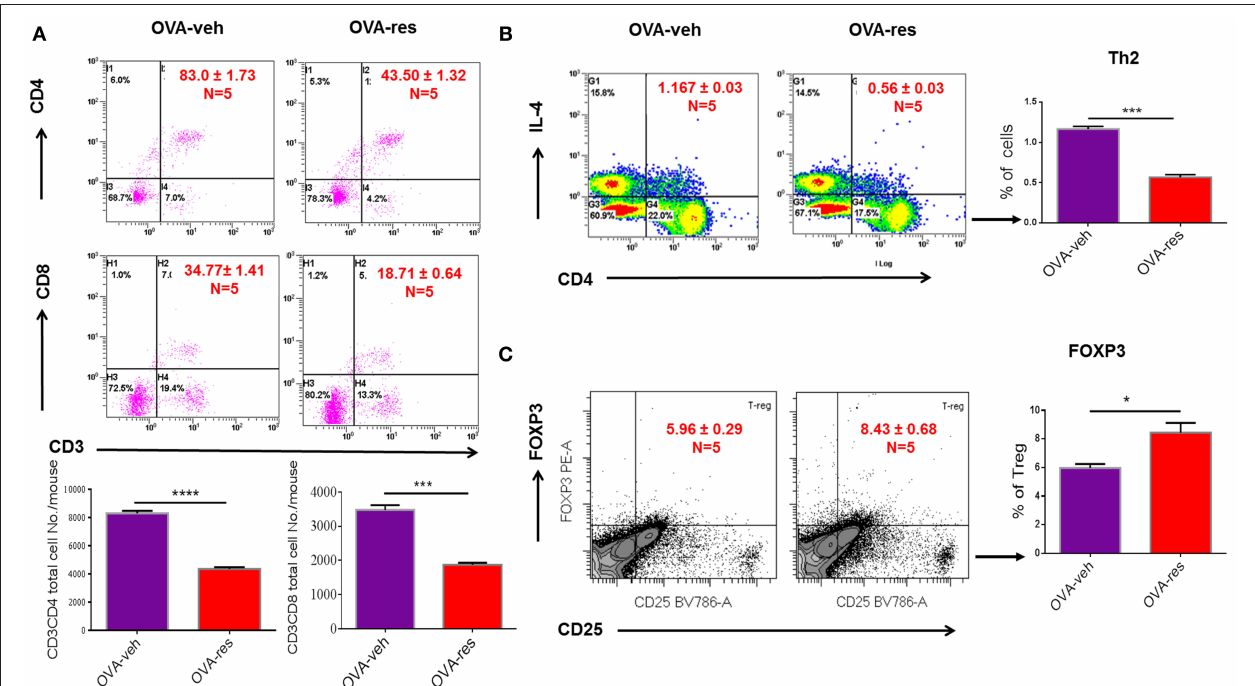
FIGURE 2 | Resveratrol decreases T cell subpopulations in lungs of OVA-administered mice. Resveratrol was used to treat OVA-induced asthma as described in Figure 1. Lung infiltrating inflammatory cells were stained by flow cytometry. (A) Shows a representative flow cytometric analysis of CD3 + CD4 + and CD3 + CD8 + T cells. Data presented in percentage in each Flow data represent the value of three independent experiments. Vertical bars represent total cell number/mouse (Mean + /– SEM) from multiple experiments. (B) Shows a representative flow cytometric analysis of CD4 + IL4 + Th2 cells. (C) Shows a representative flow cytometric analysis of CD25 + FoxP3 + Tregs gated on CD3 + CD4 + cells. For (B,C) , vertical bars represent percentage of cells/mouse (Mean + /– SEM). The number mice used are given in parenthesis: Naïve ( n = 5), OVA-veh ( n = 5), and OVA-res ( n = 5). Asterisks (*) represent significant ( p < 0.05) difference between two groups using Student’s t -tests ( p <